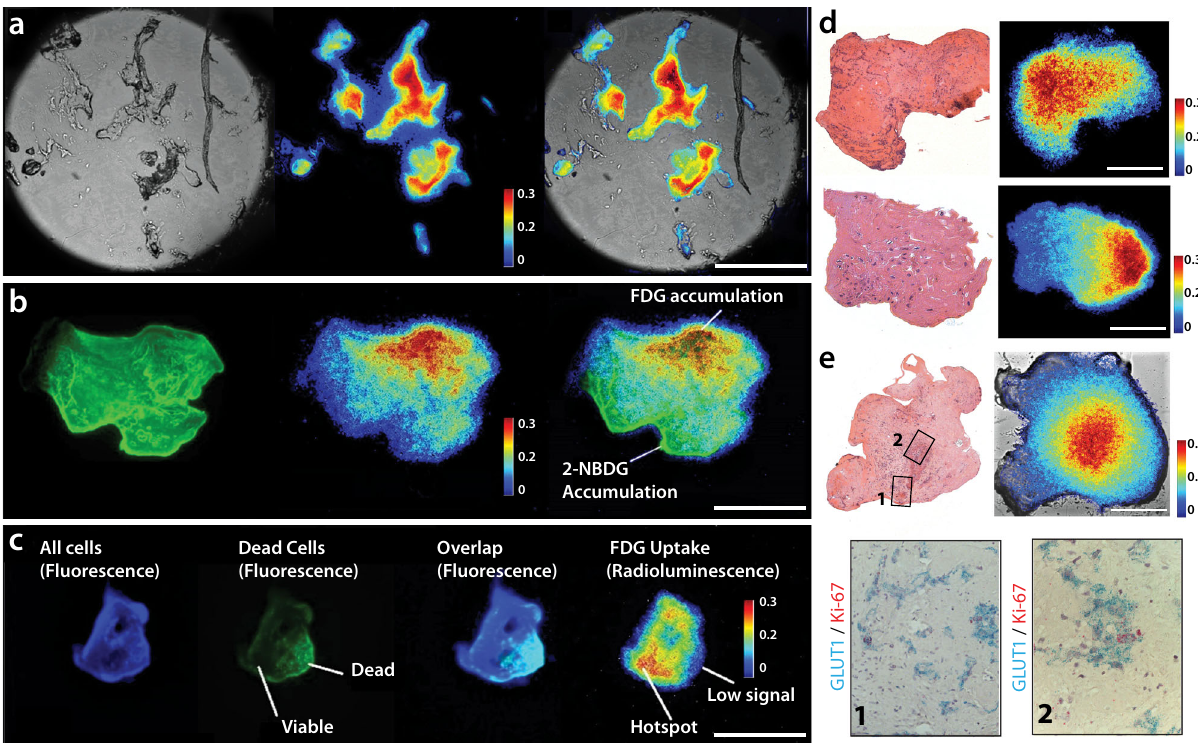
Fig. 3 Positron emission microscopy of tumor organoids. a Bright fi eld image (left), radioluminescence image (middle), and overlay (right) show the correlation between FDG uptake distribution and tissue structure. FDG uptake is elevated in most of the organoids. b Comparison between fl uorescence imaging with 2-NBDG, a fl uorescent glucose analog (left), and oPEM imaging with FDG (middle) indicates inconsistent co-localization (right) of the two probes. c Tumor organoid labeled with live/dead fl uorescent stains (three left panels) shows that FDG uptake (right panel) is associated with tissue viability. Blue: Hoechst 33342 (all nuclei), Green: SYTOX green (dead nuclei). d FDG-oPEM of human oral squamous cell carcinoma organoids (whole mount) and co-registration with H&E staining of organoid sections. e Two different regions of an H&E section and its corresponding whole mount FDG- oPEM/BF (top panels) co-registered with in situ hybridizations (bottom panels) showing expression of the glucose transporter GLUT1 (blue) and cell proliferation marker Ki67 (red). The color bar shows radioactivity (Bq/pixel). Scale bar: 0.5